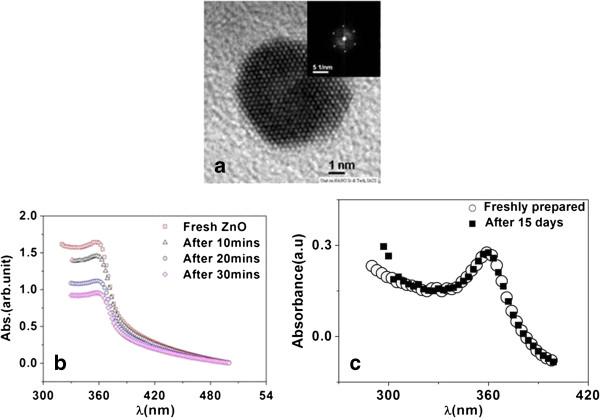
TEM image of ZnO nanocrystal used. (a) Time dependence of UV–vis spectra for ZnO nanofluids, (b) without and (c) with PVP stabilizer.